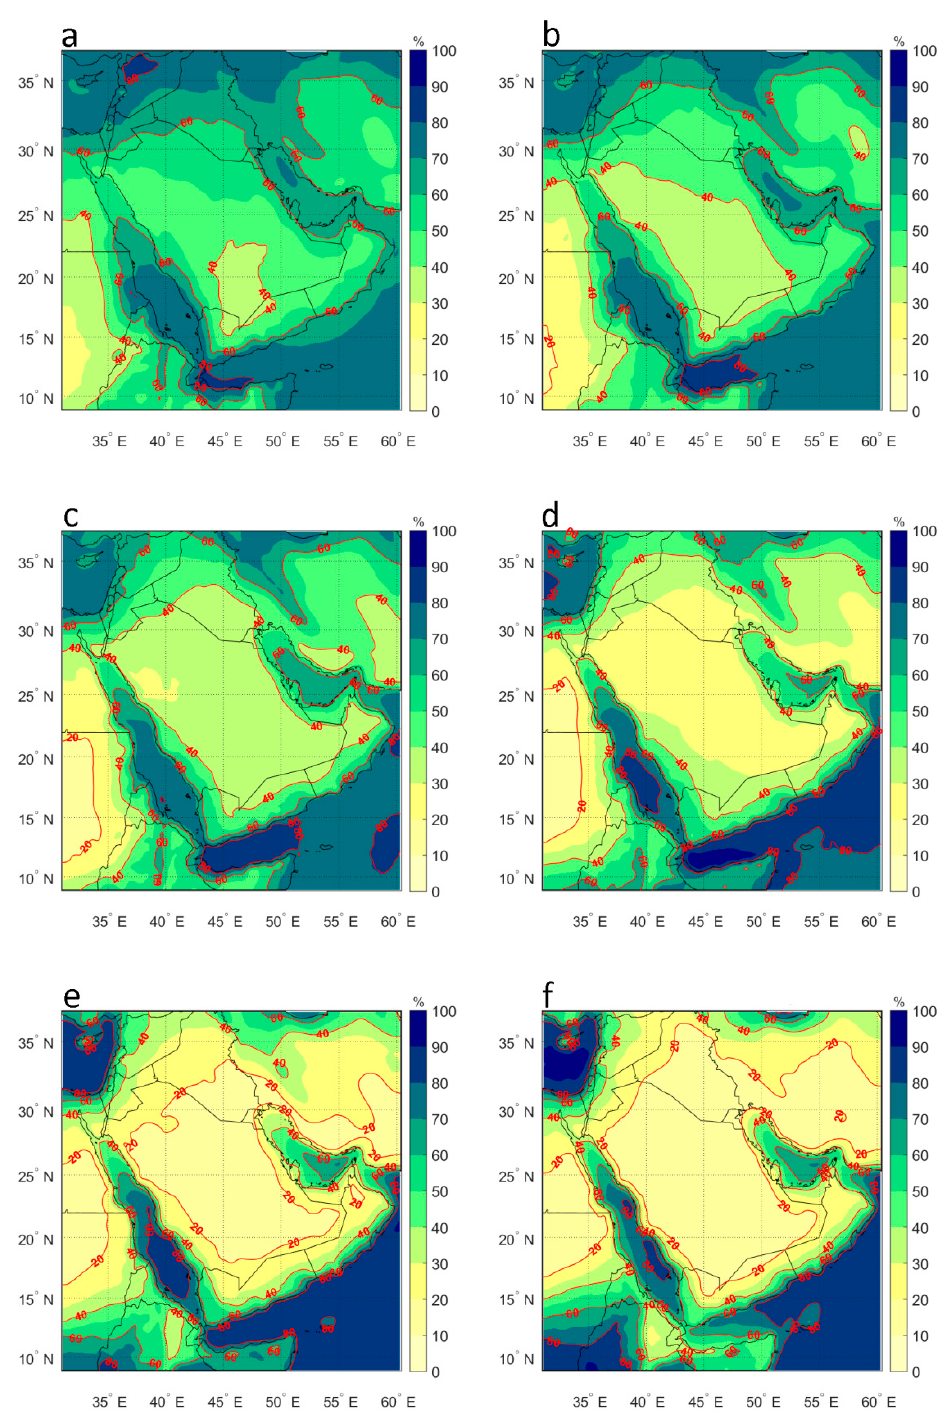
Figure A7. Mean relative humidity for the months January to June ( a – f ).